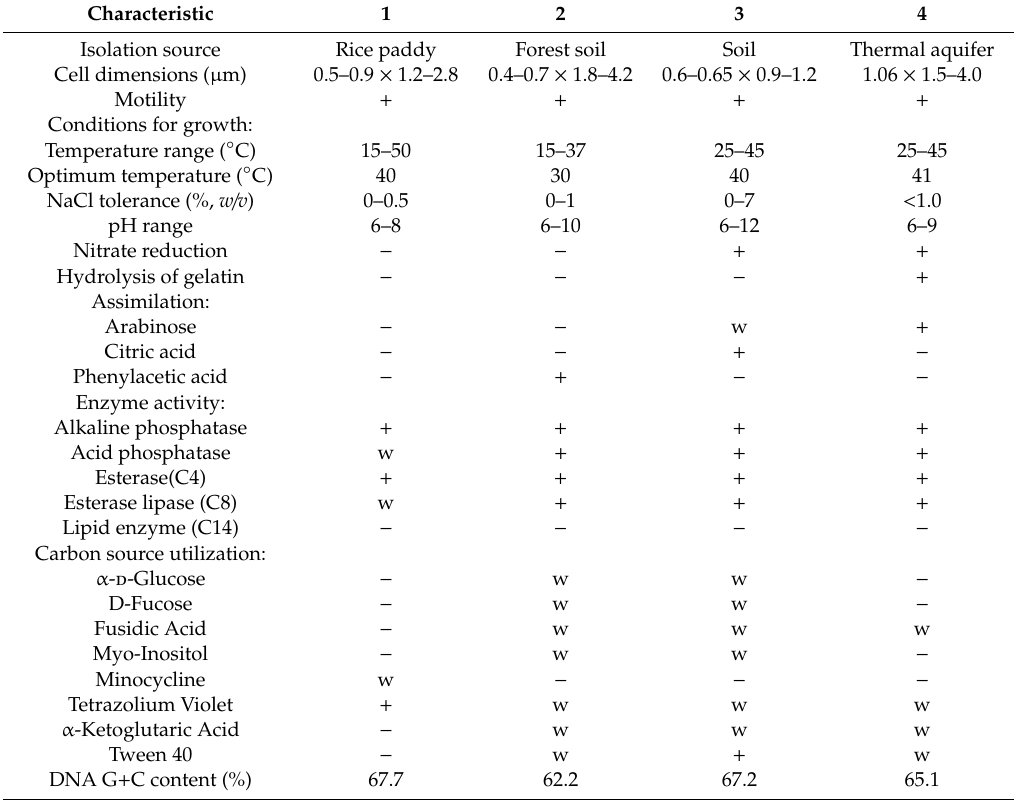
Table 1. Di ff erential physiological characteristics between strain HR1 and closely related type strains and type species of the genus Microvirga (Strains: 1. M. thermotolerans HR1 (data from this study); 2. M. flavescens c27j1 (data from this study); 3. M. indica S-MI1b (data from this study); 4. M. subterranean FaiI4 (data from this study); + : positive; w: weakly positive; − : negative; Nitrate reduction, hydrolysis and assimilation test by using API 20NE, Enzyme activity test by using API ZYM, carbon source utilization test by using Biolog.